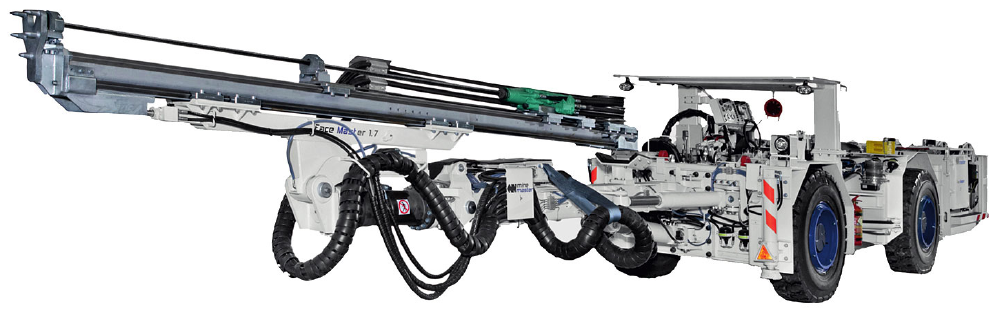
Figure 1. The drilling machine used in